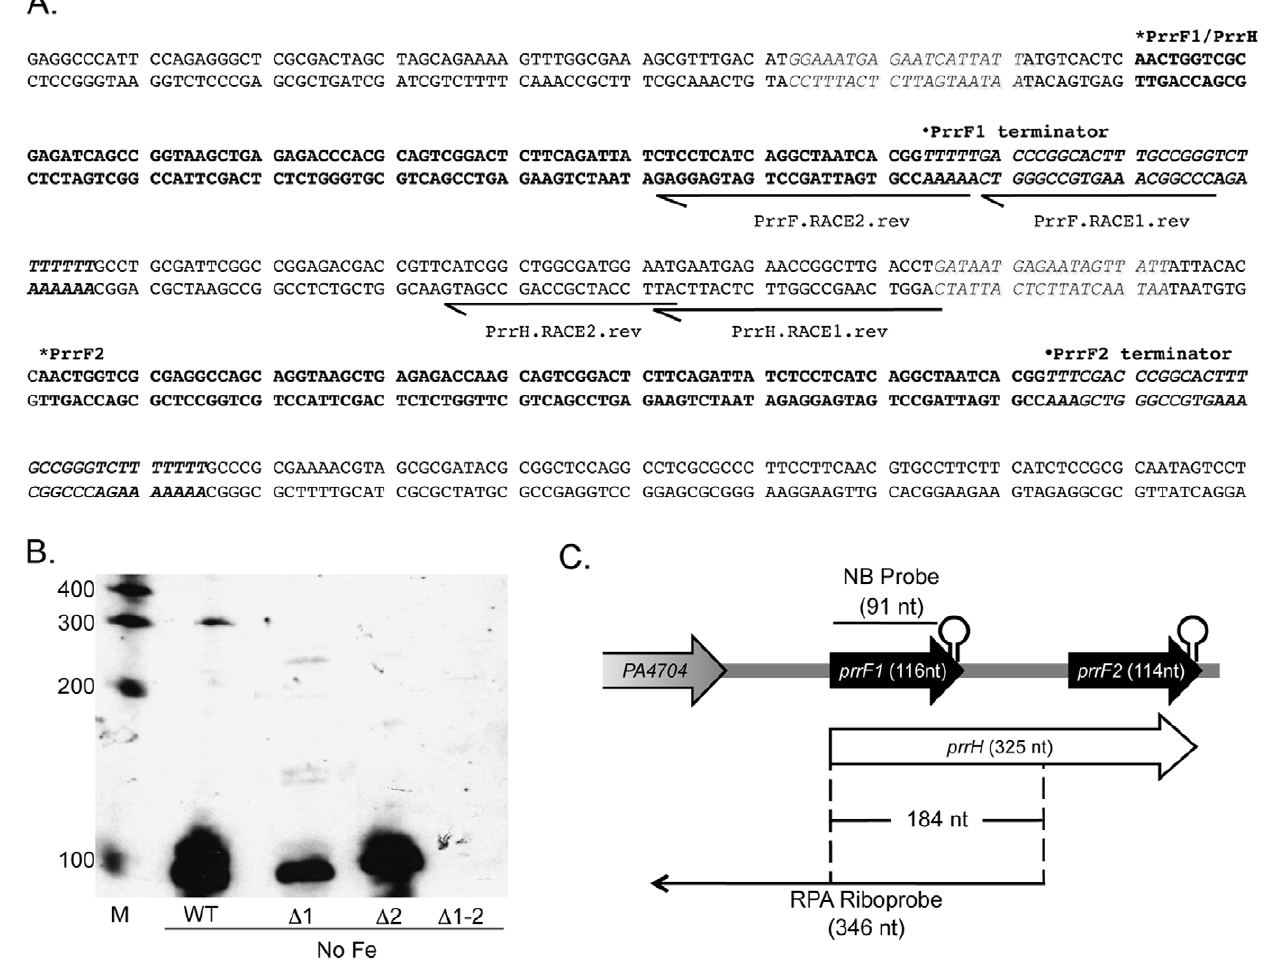
Figure 2. Identification of the PrrF and PrrH transcripts. A. Sequence of the prrF locus, showing the location of the transcriptional start sites for PrrF1, PrrF2, and PrrH determined by 5 9 RACE as described in the Materials and Methods. The coding sequence of PrrF1 and PrrF2 is indicated by bold, the Fur binding sites preceding each prrF gene are indicated by italics, and the PrrF1 and PrrF2 Rho-independent terminators are indicated by bolded italics. B. Northern analysis of the PrrF and PrrH RNAs as described in the Materials and Methods, performed with RNA from PA01 wild type, D prrF1 , D prrF2 , and D prrF1-2 strains grown for 18 hours in CM9 + 1% glycerol. M – RNA size marker. C. Map of the prrF locus, showing the primer and probe binding sites for 5 9 RACE, northern analysis, and previous RNase protection assays